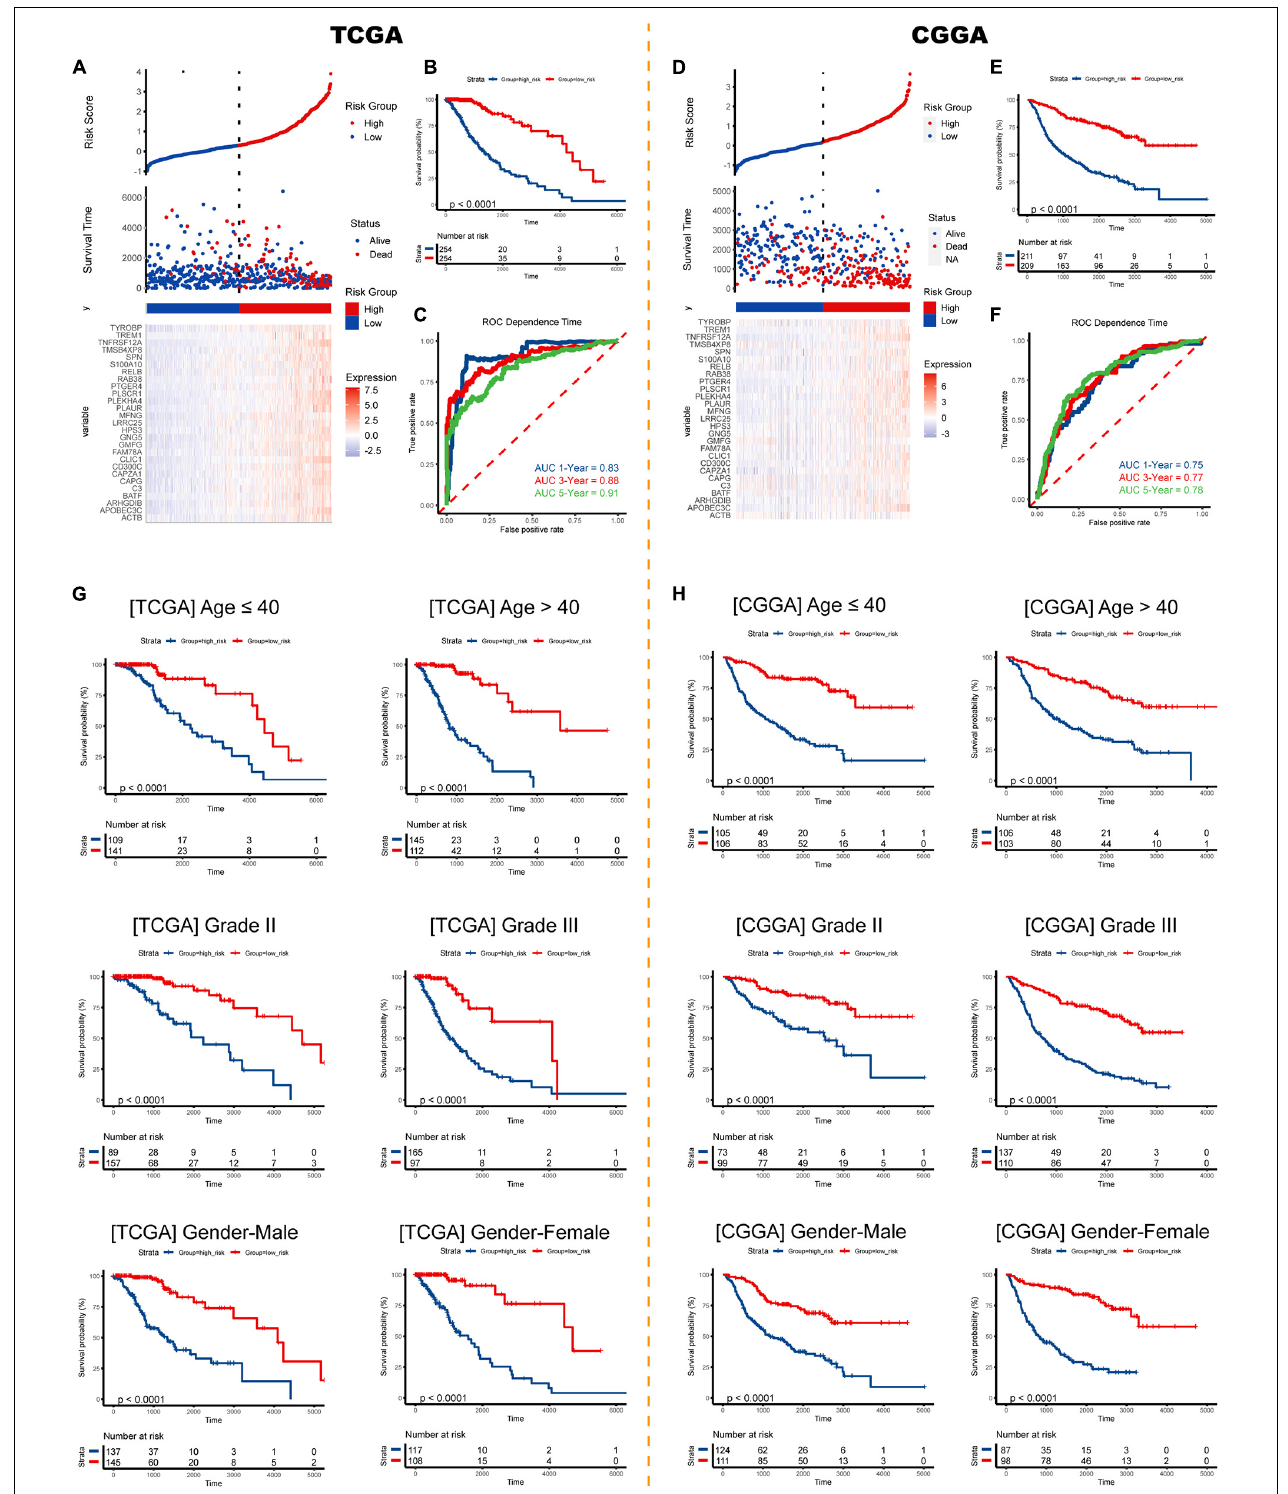
FIGURE 6 | Validation of the risk signature. Risk score, survival status, and expression pattern of model genes in the (A) TCGA cohort and (D) CGGA cohort. Kaplan-Meier analysis of patients in the high- and low-risk groups in the (B) TCGA cohort and (E) CGGA cohort. Time-dependent ROC analysis of risk score in predicting prognoses in the TCGA cohort (C) and the CGGA cohort (F) . Survival analyses in subgroups in the (G) TCGA cohort and (H) CGGA cohort. ROC, receiver operating characteristic.